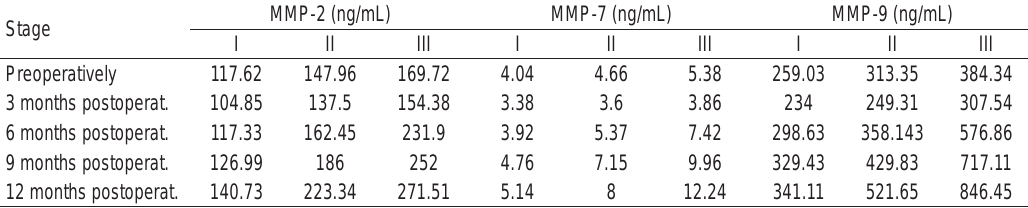
TABLE 2. Mean serum levels of MMP-2, MMP-7 and MMP-9 (ng/mL) in terms of disease staging and defi ned points of time